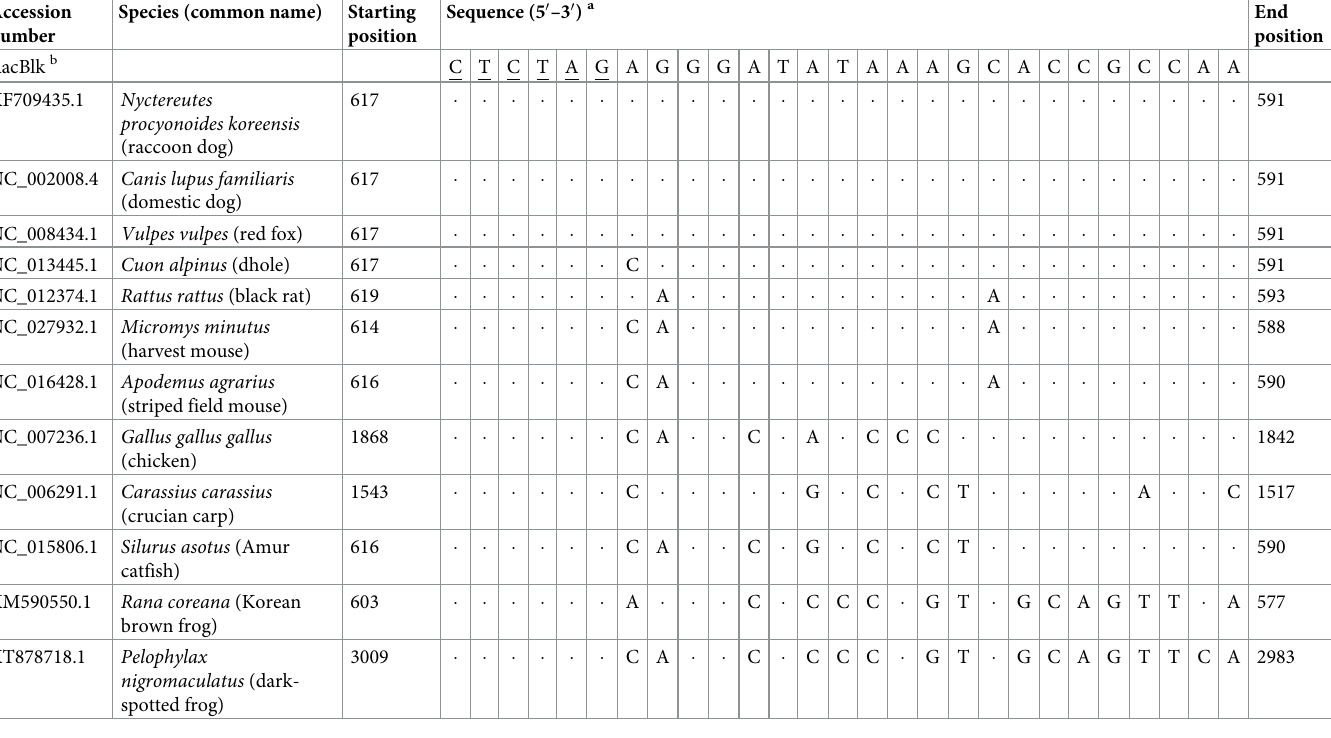
Table 1. Sequence of the blocking oligonucleotide RacBlk. The 12S rRNA gene sequences of raccoon dog ( Nyctereutes procyonoides ) and its related species and potential prey were aligned with